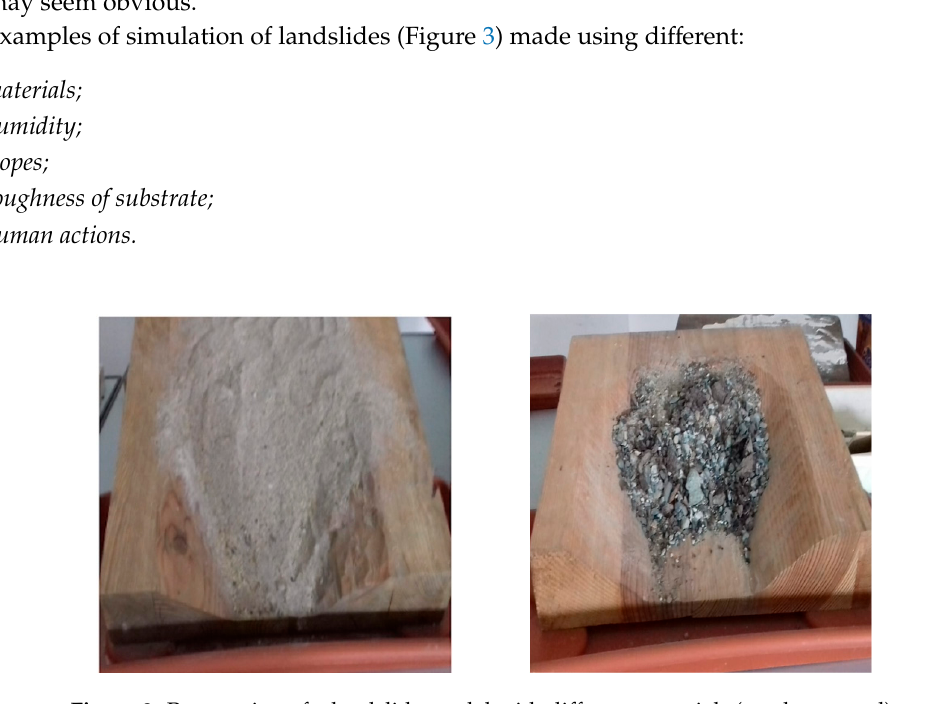
Figure 3. Preparation of a landslide model with different materials (sand or gravel).